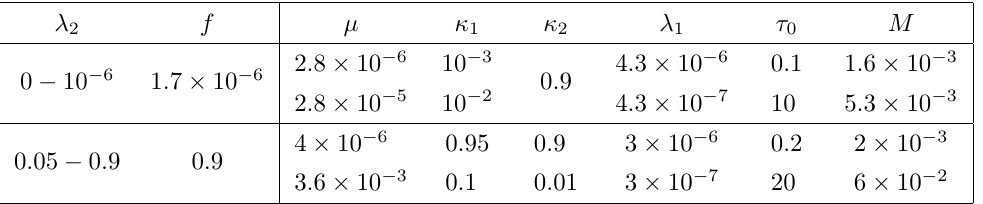
Table 2 . The numerical values of the parameters of the superpotential and the modulus vev τ 0 in the units M = 1 . We have considered B ( ξ = 0) = 1 and A ∼ 10 − 10 P